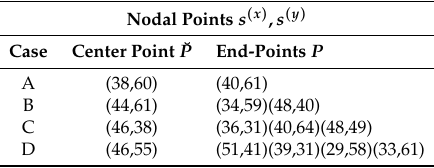
Table 4. Coordinate of the block s ( x ) , s ( y ) enclosed end-point set for the multilateral well, GA algorithm. Nodal Points s ( x ) , s ( y )